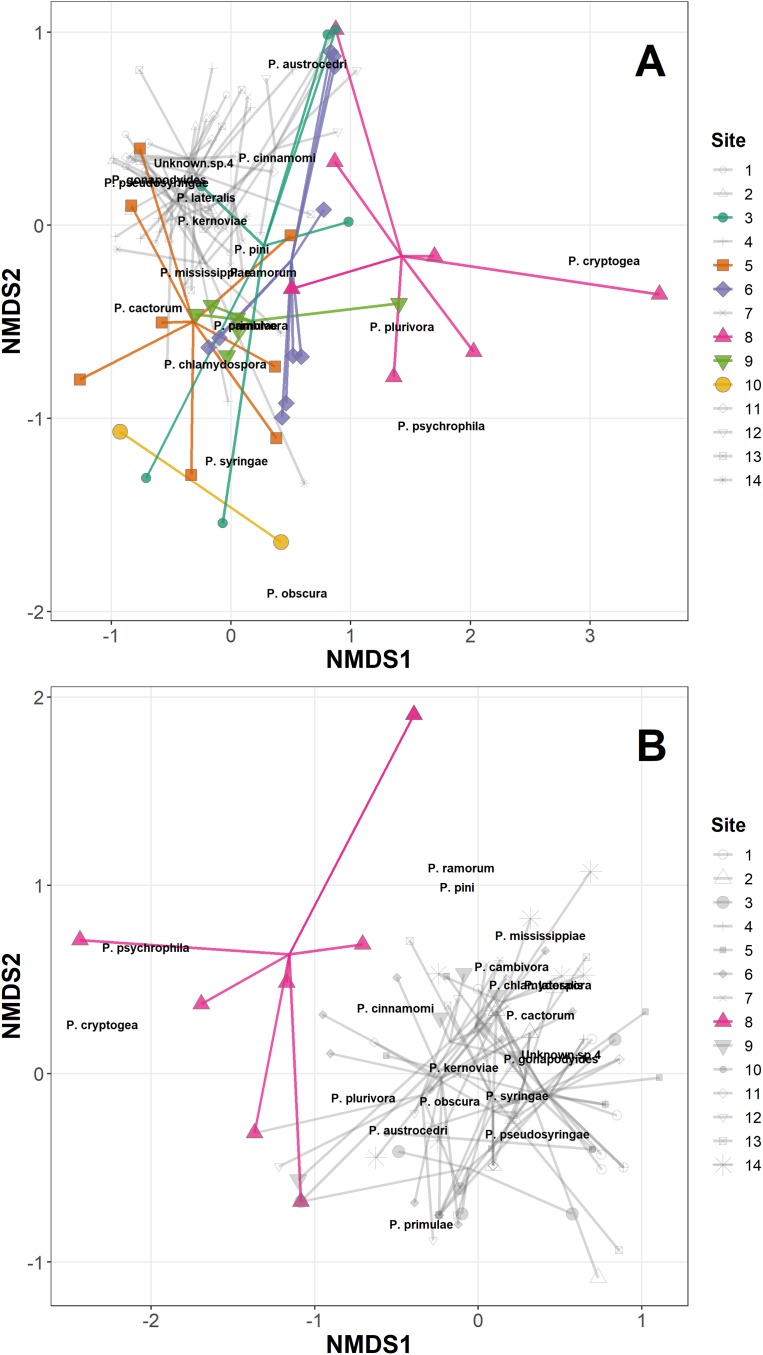
Non-metric multidimensional scaling (NMDS) of Phytophthora species abundance data (A) and Phytophthora species presence/absence data (B) (Bray–Curtis dissimilarity matrix, with centring and Wisconsin square-root transformations, two of three axes), with ‘ordispider’ plots showing the significant effect of site on the distances (permANOVA, (F13,98 = 2.93, p < 0.001, abundance data; F13,98 = 2.92, p < 0.001, presence/absence data)).Those sites occupying markedly different ordination spaces are highlighted (colour, opaque); cluster of sites with similar ordinations are muted (greyscale, transparent).